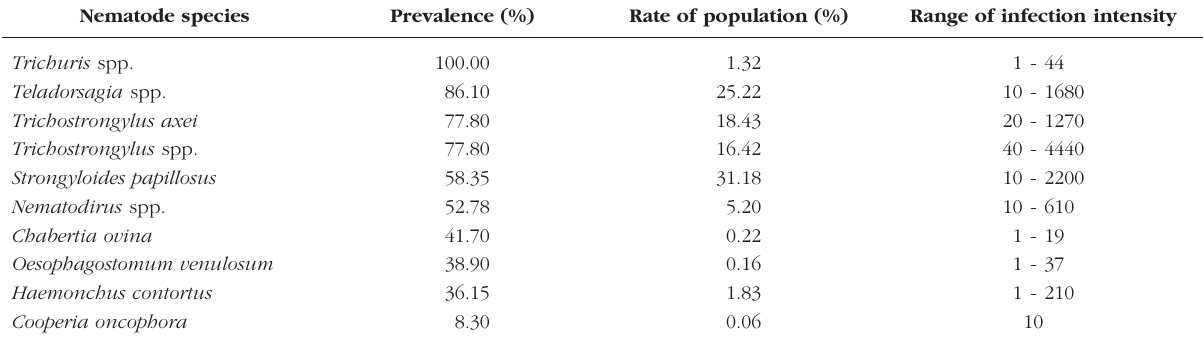
Table I. – Proportion (in %) of different nematode genus recovered after necropsy of tracer lambs.